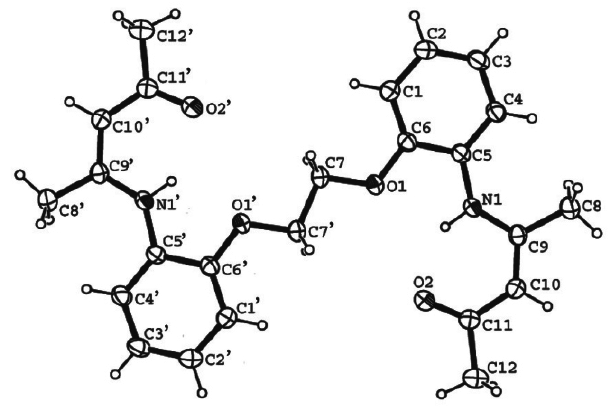
Table 1. Data collection and handling.